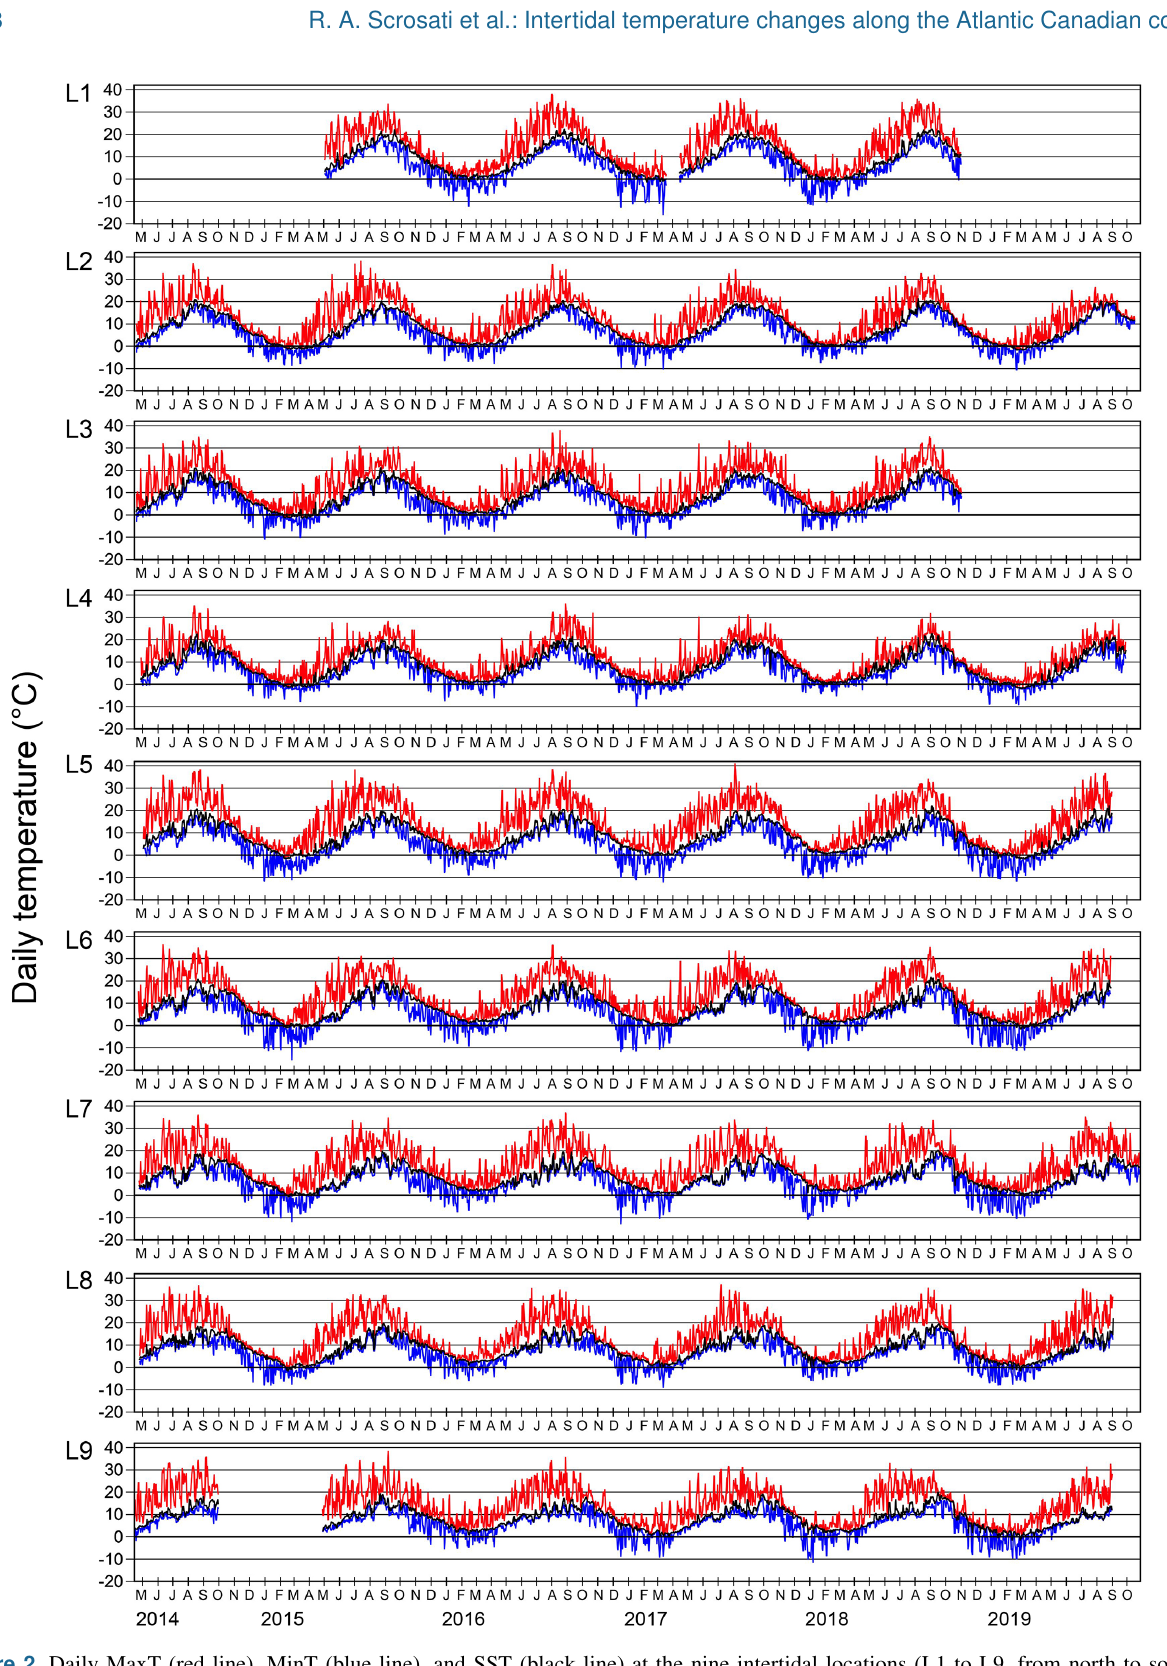
Figure 2. Daily MaxT (red line), MinT (blue line), and SST (black line) at the nine intertidal locations (L1 to L9, from north to south) surveyed between April 2014 and October